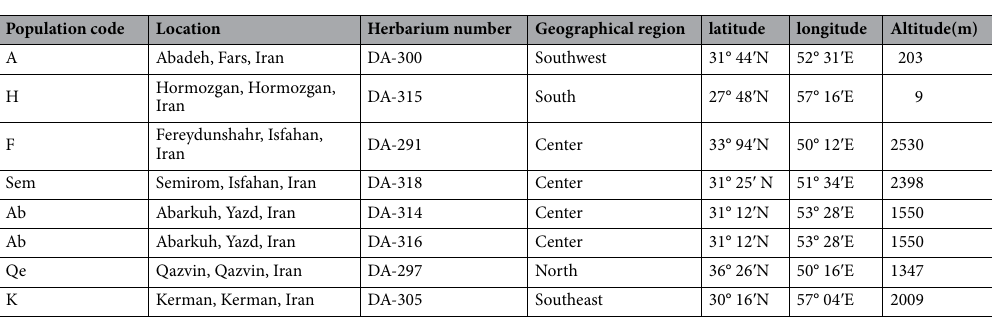
Table 6. Geographical location and their characteristics of 8 Moshgak